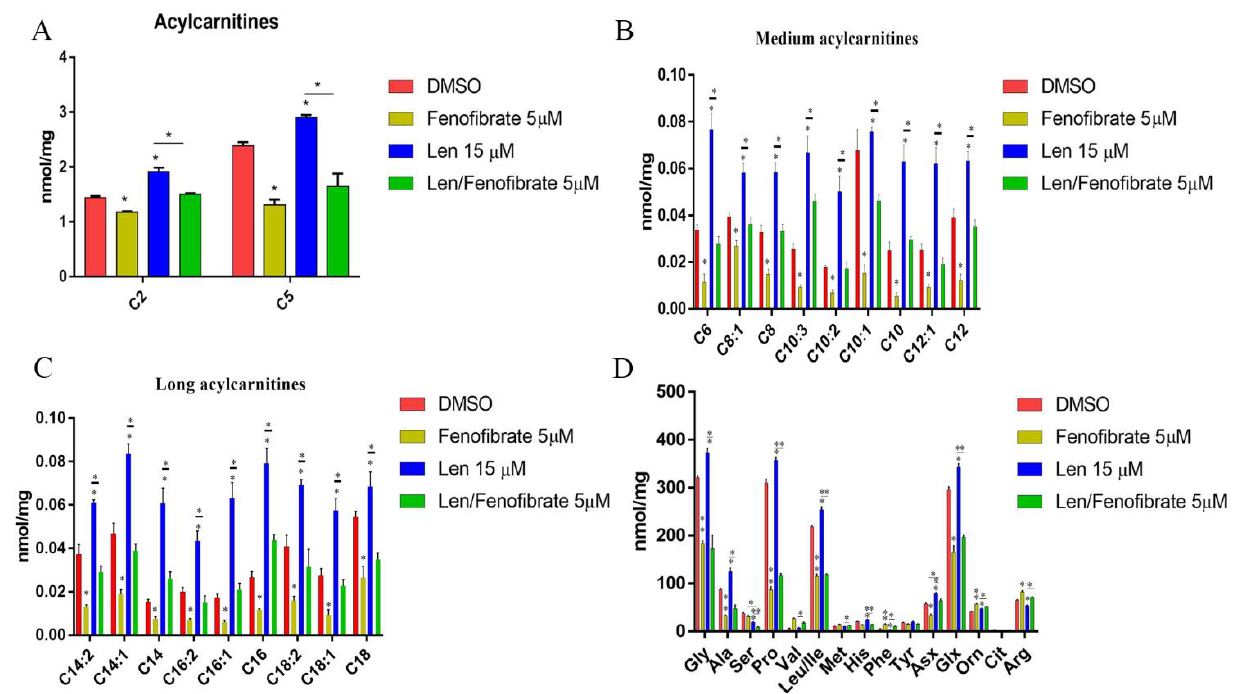
Figure 4. Fenofibrate and lenalidomide has opposite effects of lipid and amino acid metabolism. ( A ). MM1.R was treated with DMSO control, 5 µM Fenofibrate, 15 µM lenalidomide, and a combination group 48 h. Collect samples and subject to the Duke Metabolic Core Facility. C2, C5 Acylcarnitines ( A ), medium-chain acylcarnitines ( B ), long-chain acylcarnitines ( C ) and several amino acids ( D ) were analyzed. *: p < 0.05; **: p < 0.01.